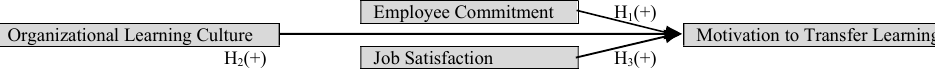
Fig. 1. Conceptual Model of the